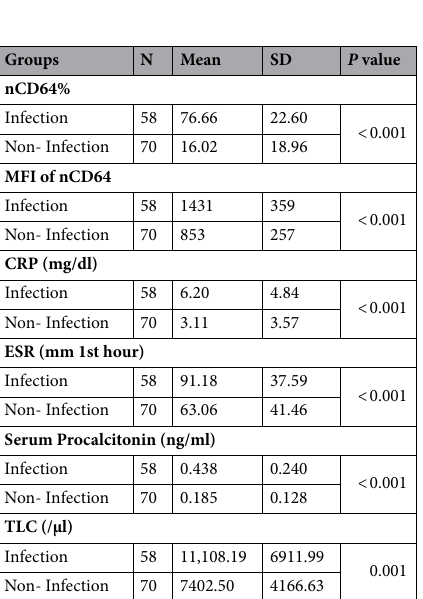
Table 2. Biomarkers to differentiate between infection vs inflammation in severe alcoholic hepatitis. Data is presented as mean ± SD. Independent samples t test used. #Presented in median (interquartile range) and compared by Mann Whitney U test used. p < 0.05 significant. nCD64% Neutrophils CD64 expression in percentage, MFI Mean fluorescence intensity, CRP C-reactive protein, ESR erythrocyte sedimentation rate, TLC total leukocyte